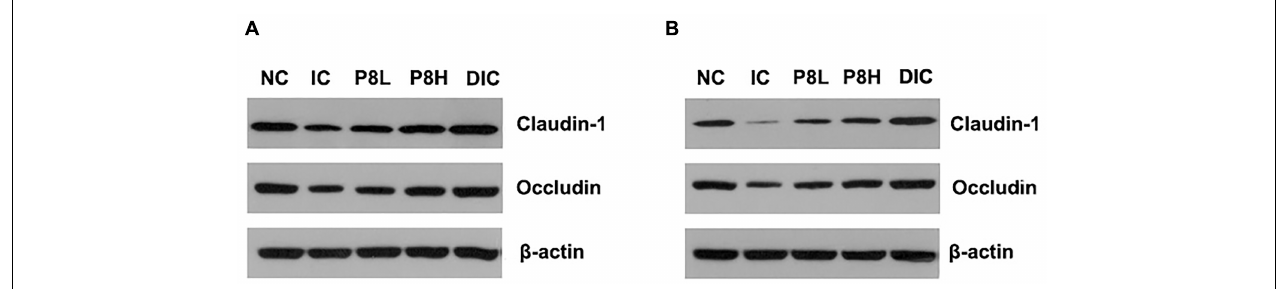
FIGURE 2 | Effects of P8 on the expression of jejunal Claudin-1 and Occludin of Eimeria -infected broilers. (A) Day 21, (B) day 42.